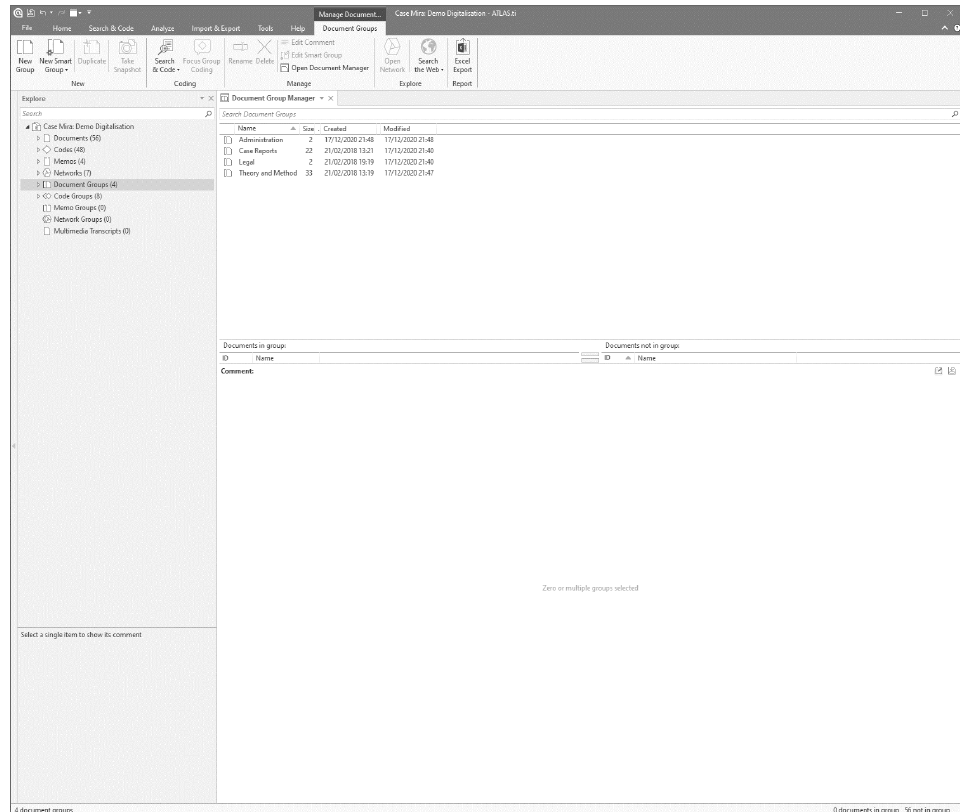
Figure 2 . Example of documents in ATLAS.ti . Figure 2. Example of documents in